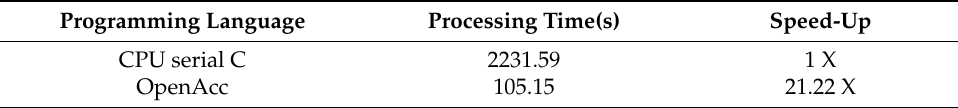
Table 4. Performance of OpenACC implementation.